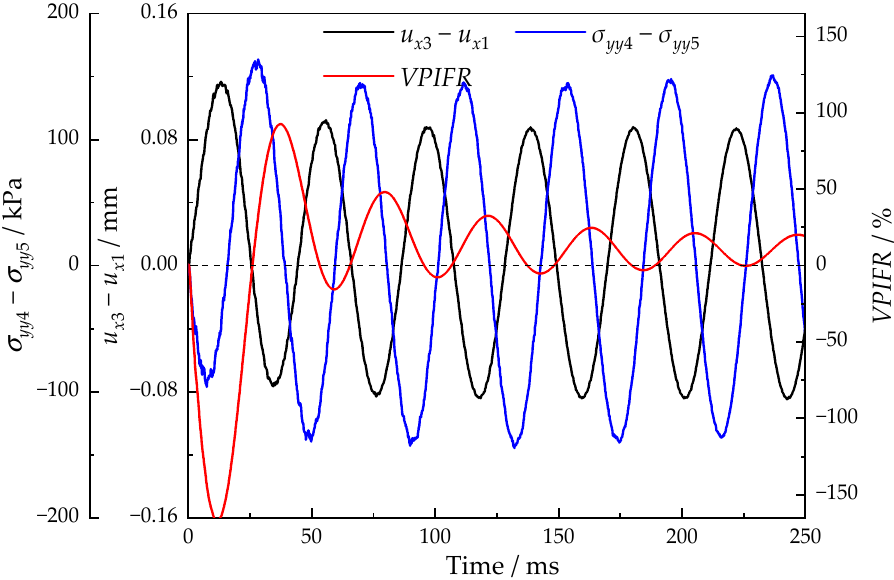
Figure 15. Variation in the interdendritic feeding gap size ( u x 3 − u x 1 ), the interdendritic feeding pres- sure ( 𝜎 yy 4 − 𝜎 yy 5 ), and the VPIFR value under vibration with time. pressure ( σ − σ yy 5 ), and the VPIFR value under vibration with yy 4